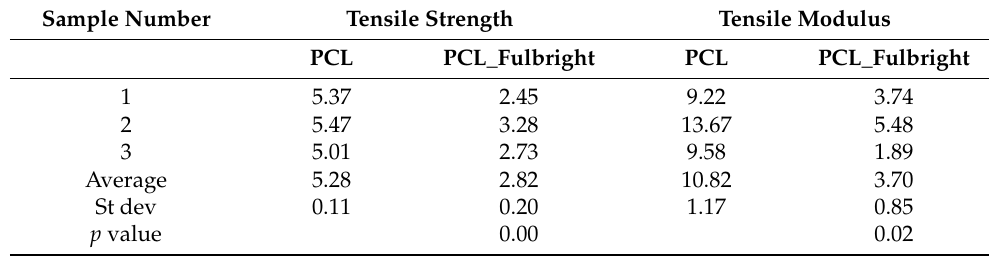
Figure 12. Stress–strain curve of pull-out tension tests showing the difference between the strain and stress for PCL and PCL_Fulbright cloths. Table 1. Mechanical test results of PCL and PCL_Fulbright samples. The data are presented as mean ± standard of error for sample size, n = 3.